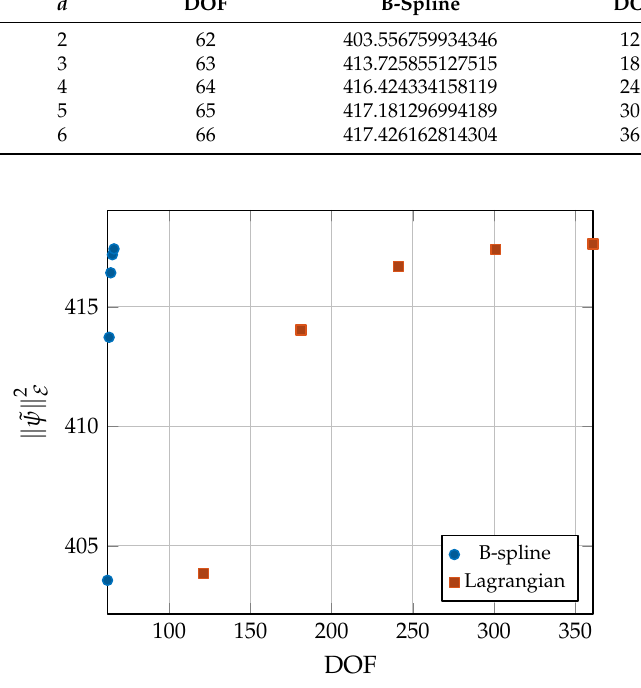
Figure 24. Squared space-time energy norm (60) of the IGA- and standard Energetic BEM approximate transient solutions, for increasing degree d , plotted with regard to DoFs.